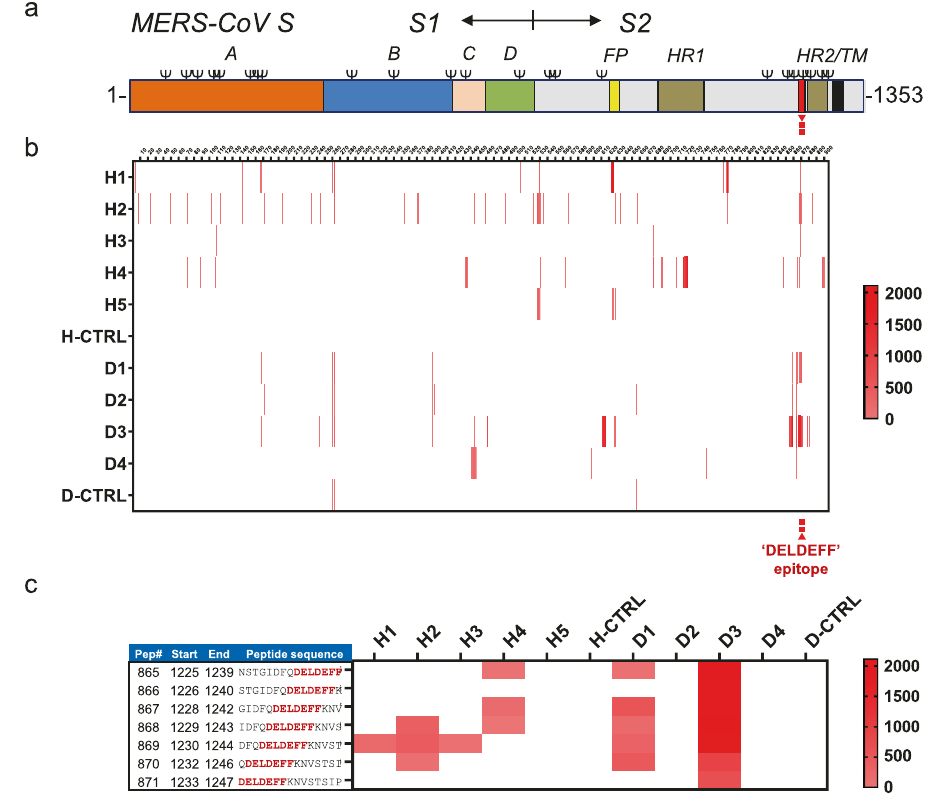
Fig. 6 Antibodies towards the stem helix epitope are elicited during natural infection. a Schematic representation of the MERS-CoV spike protein. The spike subunits (S1 and S2), S1 domains (A through D), fusion peptide (FP), heptad repeat 1 (HR1), heptad repeat 2 (HR2) and transmembrane domain (TM) are annotated. b Spike protein peptide microarray analysis using MERS-positive human and dromedary camel sera. 905 overlapping peptides covering the entire MERS-CoV S ectodomain (residues 1 – 1296) were synthesized with an offset of one or two residues. The binding of fi ve convalescent MERS-positive human (H1 – H5) and four dromedary camel (D1 – D4) sera to the peptide library, as well as a MERS-negative serum from human (H-CTRL) or camel (D- CTRL) was assessed in a PEPSCAN-based ELISA (Lelystad, The Netherlands). A cumulative heatmap of signal intensities for individual peptides are shown. Signal intensities increase from light reddish to red, whereas white corresponds to background signal. Source data are provided as a Source Data fi le. c Reactivity of the human and dromedary sera to peptides covering the 1.6C7/28D9 epitope region (epitope core sequence highlighted in red). Source data are provided as a Source Data fi